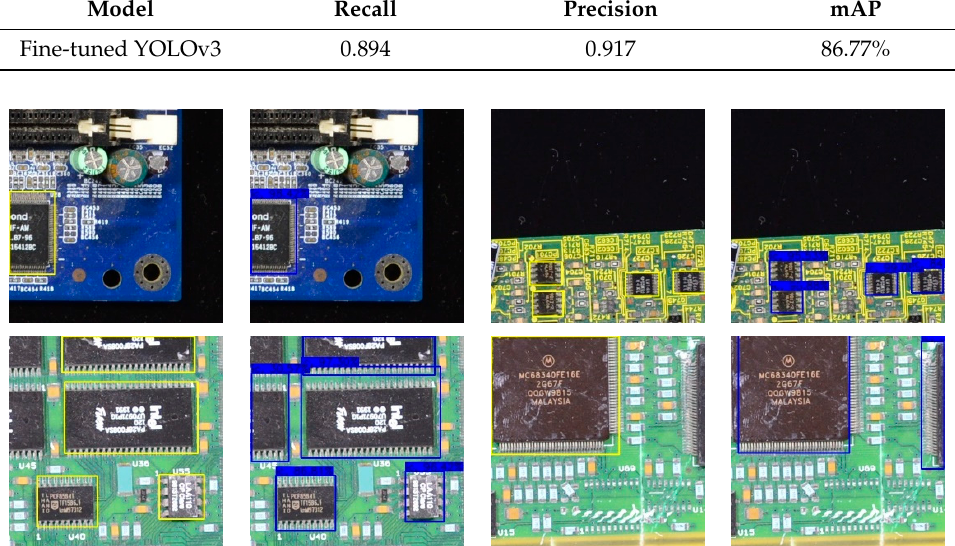
Figure 6. Some partitioned instances of the PCB DSLR Dataset, the left image pair contains the expected results and the right one the obtained results. Table 3. Precision, Recall, and mAP for the IC detector model.